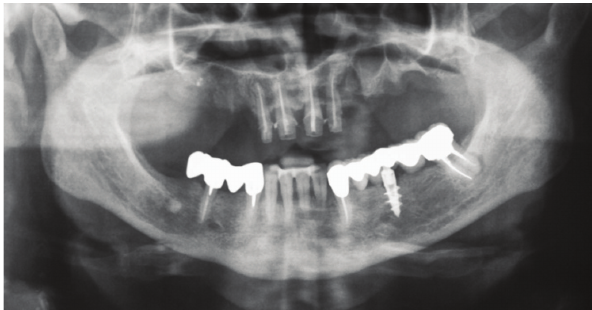
Figure 11: The radiographic image shows that bone grafts are well integrated.